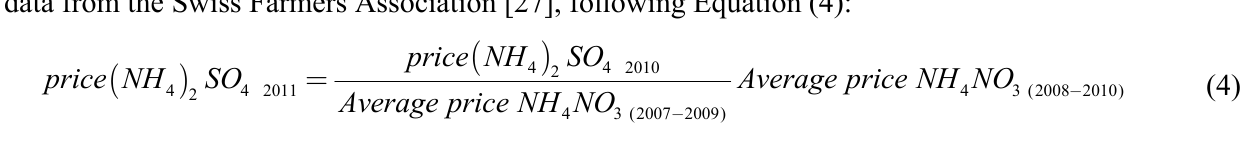
Table 4. Chemical, electricity and fertilizer